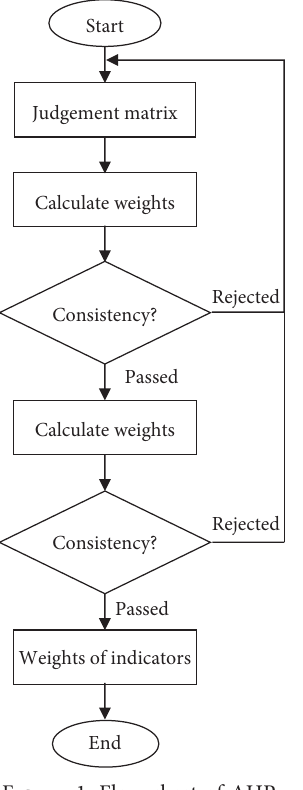
Figure 1: Flow chart of